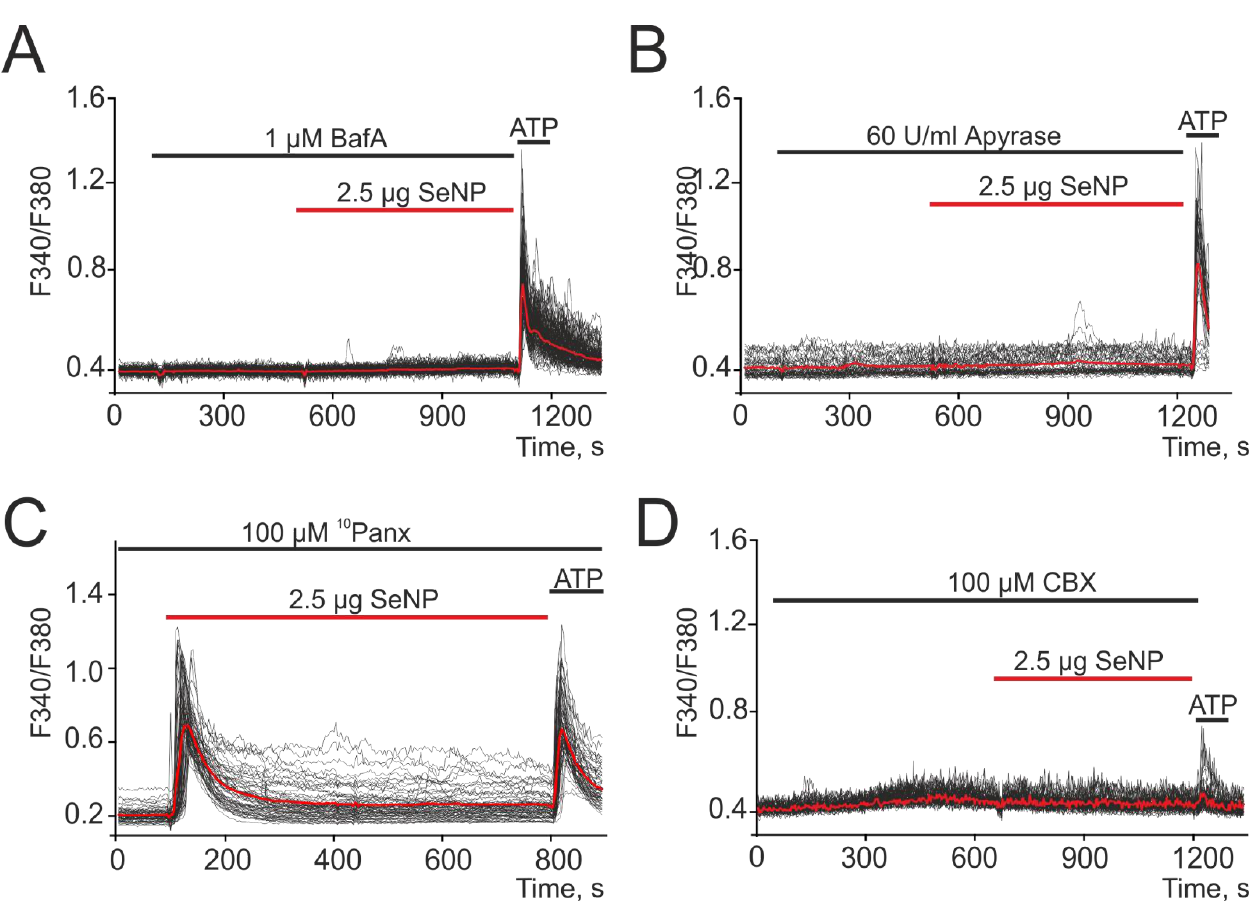
Figure 4. Suppression of Ca 2+ signals in A-172 cells in response to the application of 2.5 µg SeNPs in the presence of a vesicular secretion blocker Bafilomycin A1 ( A , Baf A1, 1 µM), apyrase ( B , 60 U/mL), an enzyme that breaks down ATP and connexin blocker Carbenoxolone ( D , CBX, 100 µM). ( C ) Pannexin blocker, 10 Panx (100 µM), did not affect the Ca 2+ signals of cells in response to SeNP. At the end of the experiment, 10 μM adenosine triphosphate (ATP) was added. Here, Ca 2+ signals of cells in one experiment and their average value (red curve) are presented.